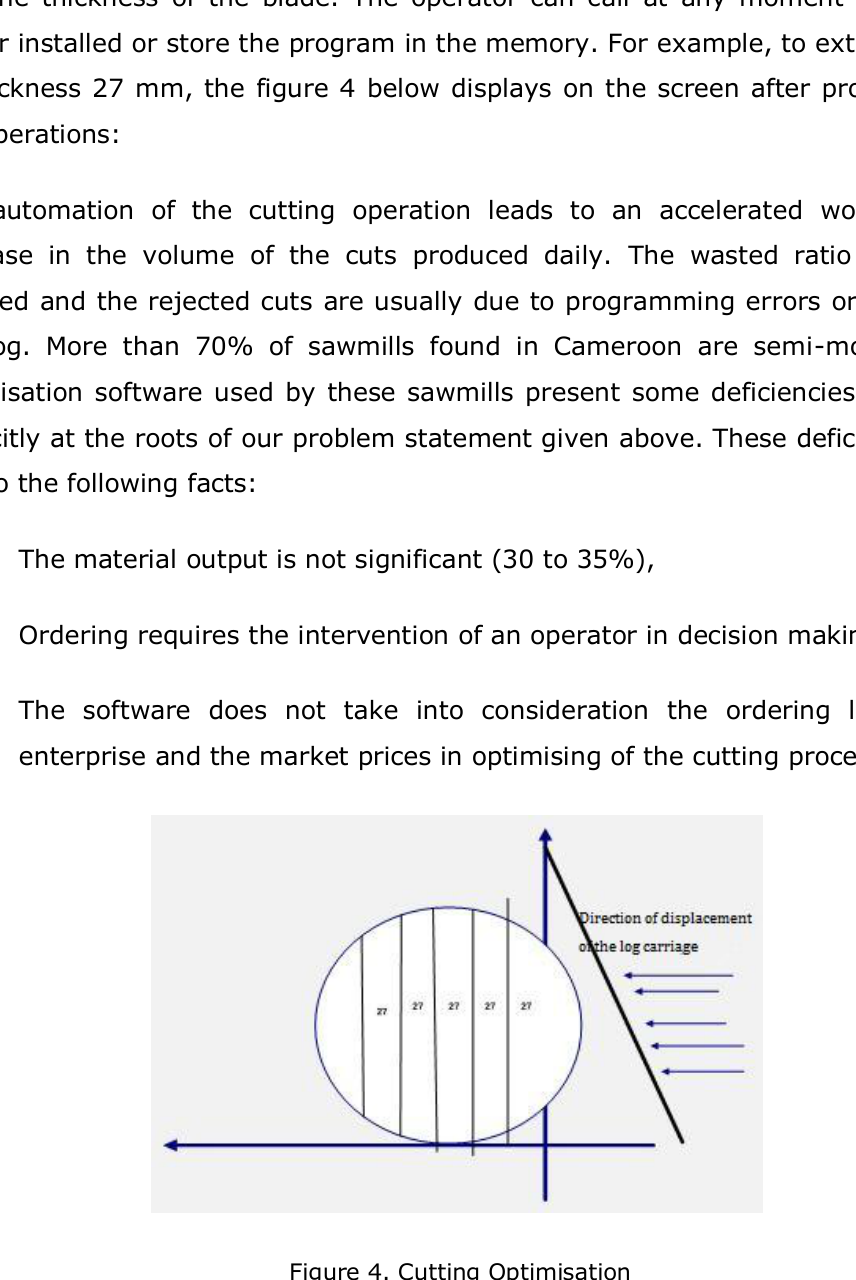
Figure 4. Cutting